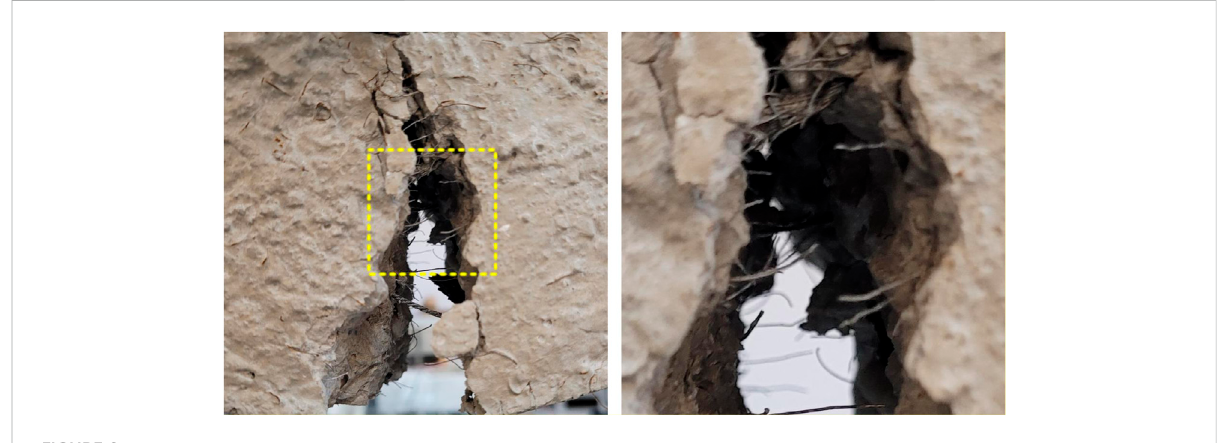
FIGURE 9 Damaged view of the beam with 3% waste fi